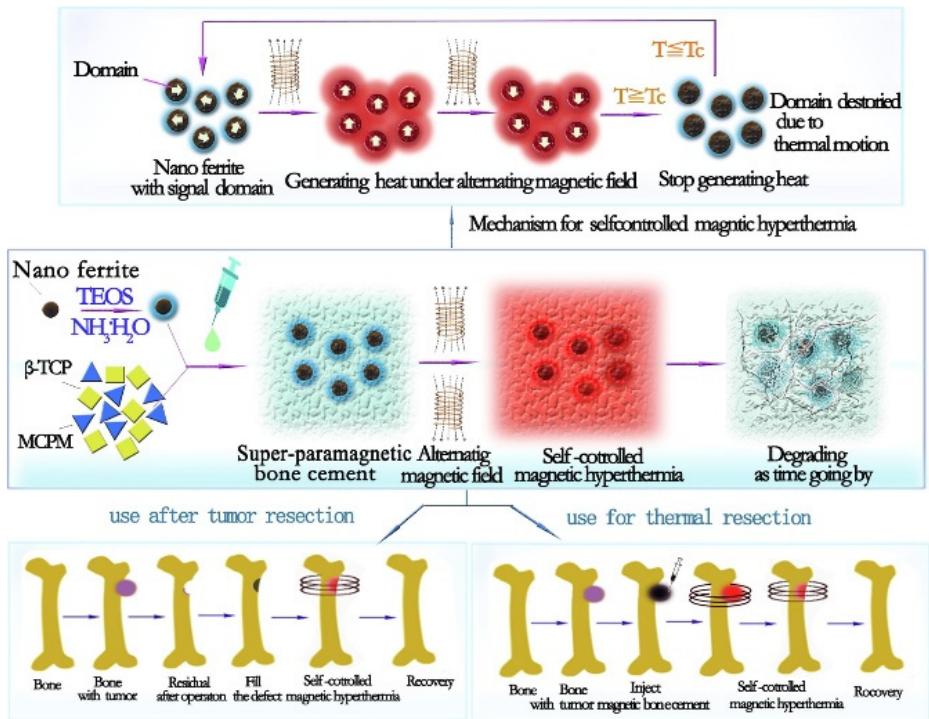
Figure 4. Theoretical schematic diagram showing the design of a magnetic nanomaterial for magnetic hyperthermia. Reproduced with permission from [167].